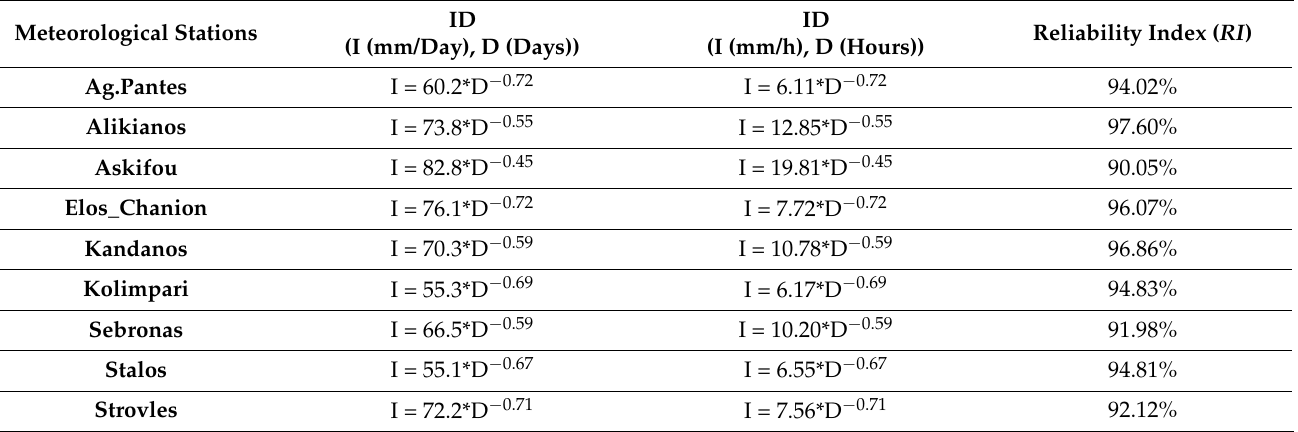
Table 1. Equations of ID